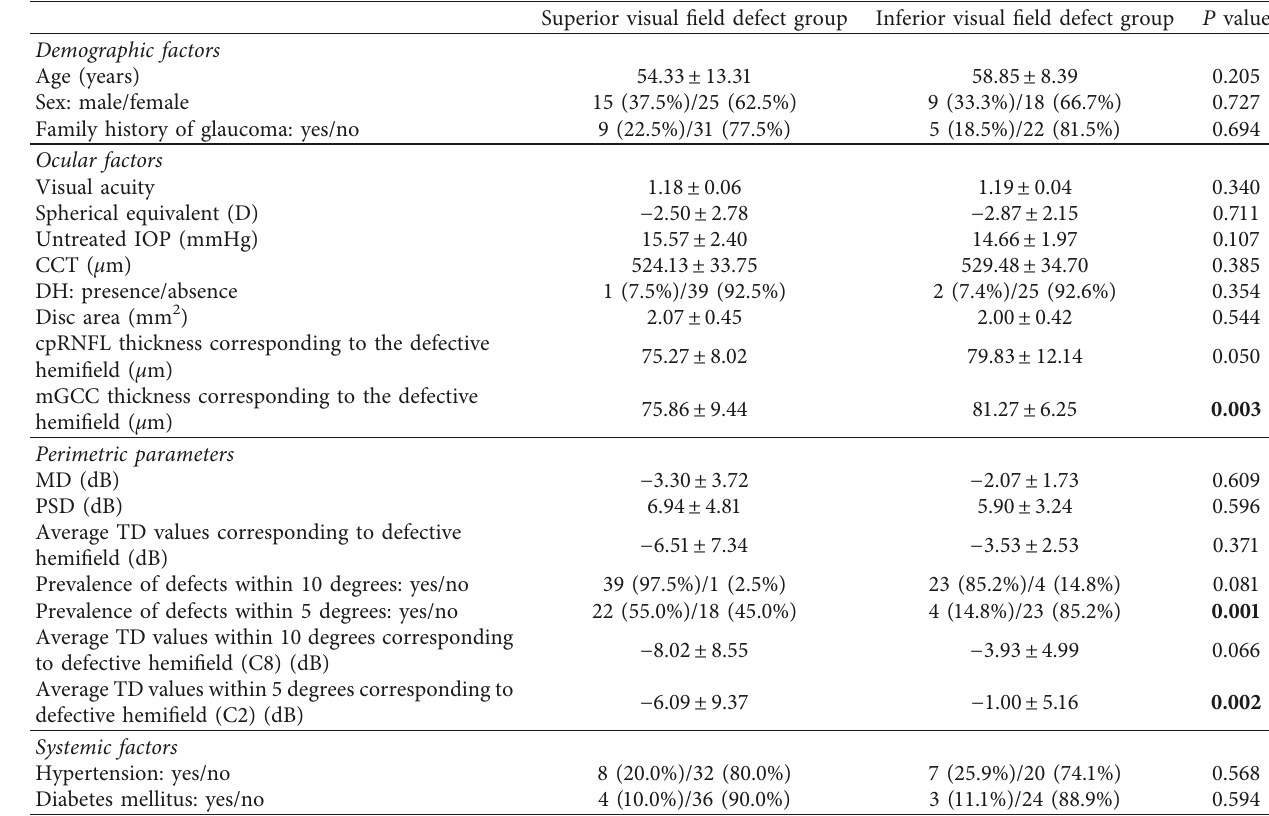
Table 2: Comparison of clinical characteristics between the superior hemifield and inferior hemifield defect groups.